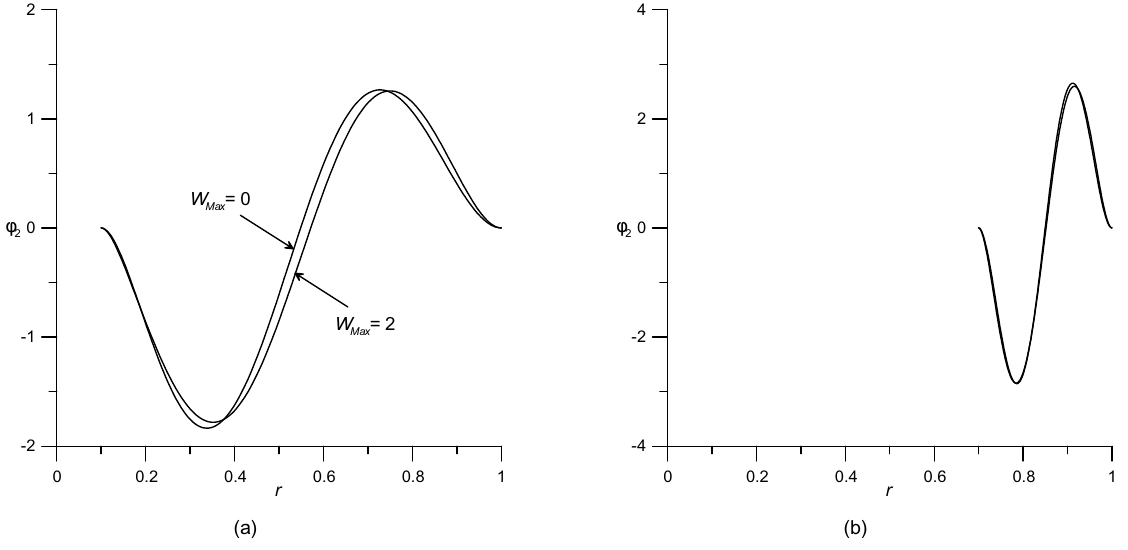
Fig. 15. The second mode shape for flat and deflected ( W Max = 2 ) clamped-clamped plate of inner radius (a) b = 0 . 1 and (b) b = 0 . 7 . a position where W Max = 2 . It was found that while